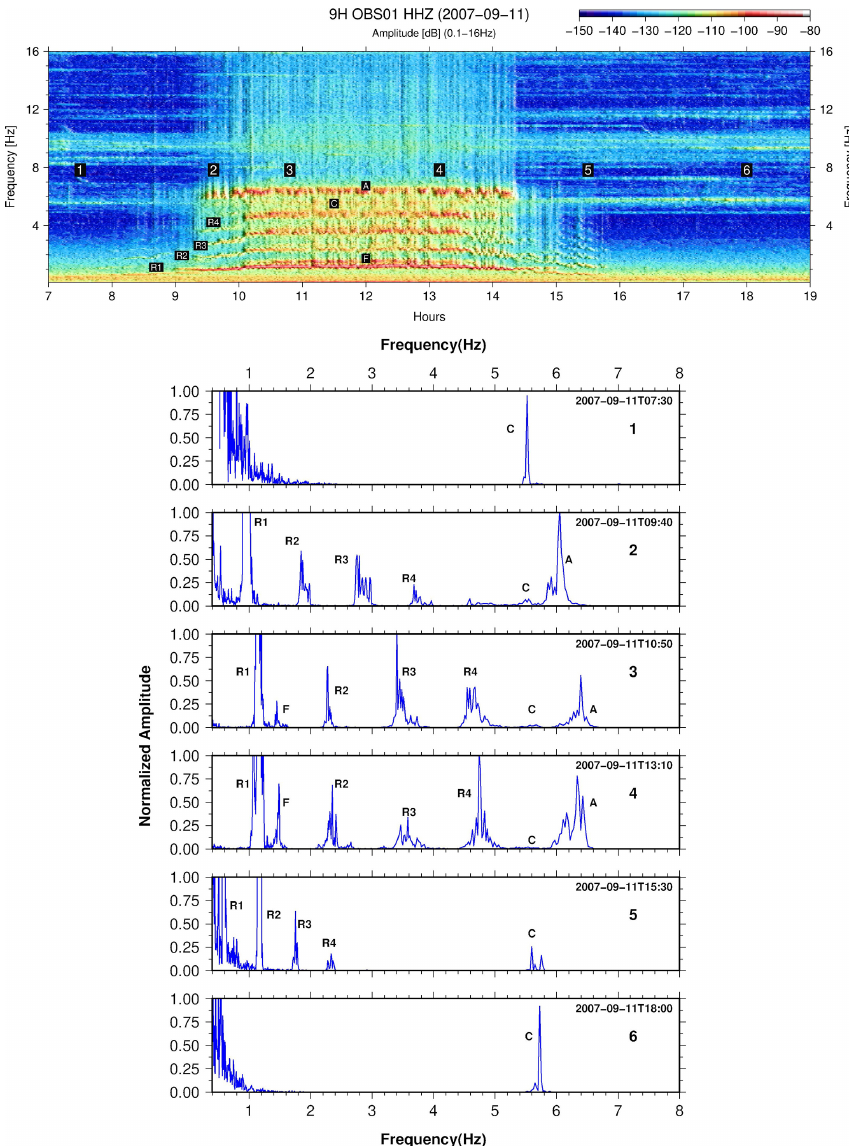
Figure 9. Harmonic tremors – the prevailing signals before, during and after the harmonic tremors. The current flow speed described in terms of (A) radio antenna, (F) flagpole, (R1) head buoy rope fundamental frequency, (R2) second, (R3) third, (R4) and fourth overtones, and (C) the natural frequency of OBS–sediment coupling. At (1) 07:30, before the harmonic tremors, with its normal vibration; (2) 09:40, observed frequency gliding in the head buoy rope; (3) 10:50, we observe mode-locking frequency on harmonic tremor; (4) 13:10, continues the previous situation in terms of frequency (mode-locking); (5) 15:30, the current flow speed is decreasing and a frequency gliding of the head buoy rope is observed; (6) 18:00, the harmonic tremor is no longer active and the natural frequency of OBS–sediment coupling returns to